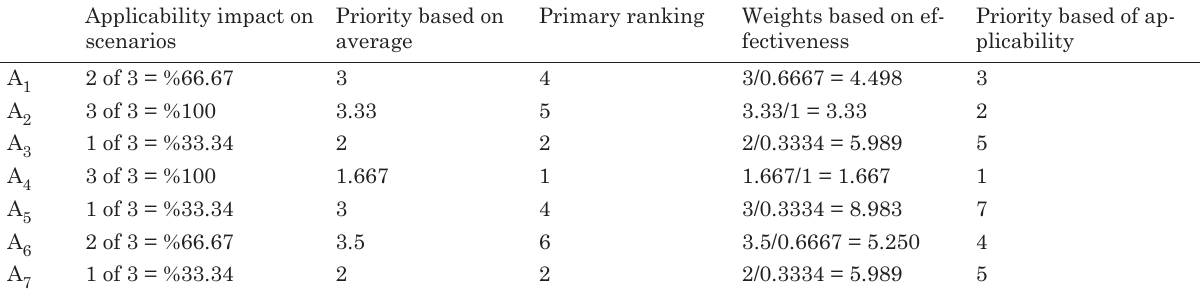
Table 17. investigation on effectiveness of criteria based on